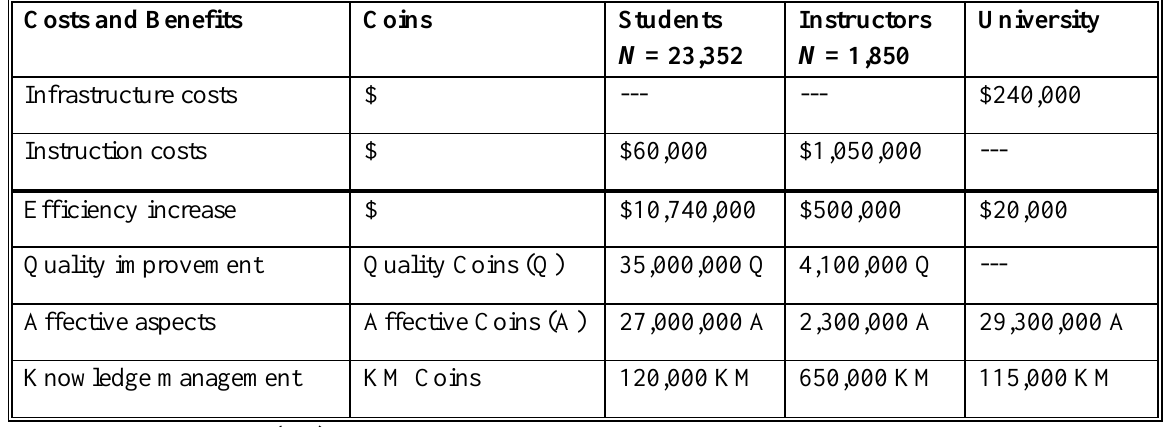
Summary of the Cost and Benefit